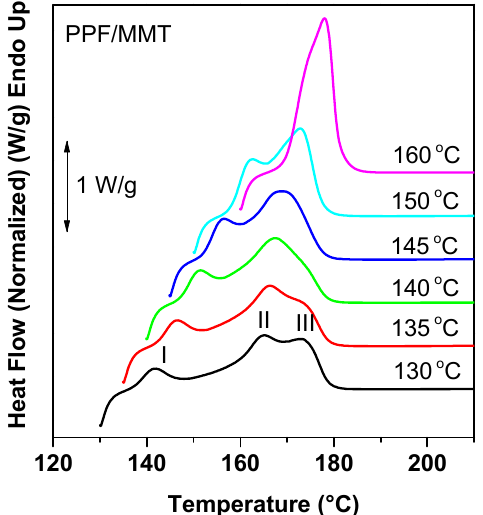
Figure 8. DSC traces for PPF-MMT-Na sample, crystallized at different temperatures. The applied heating rate was 20 °C/min.